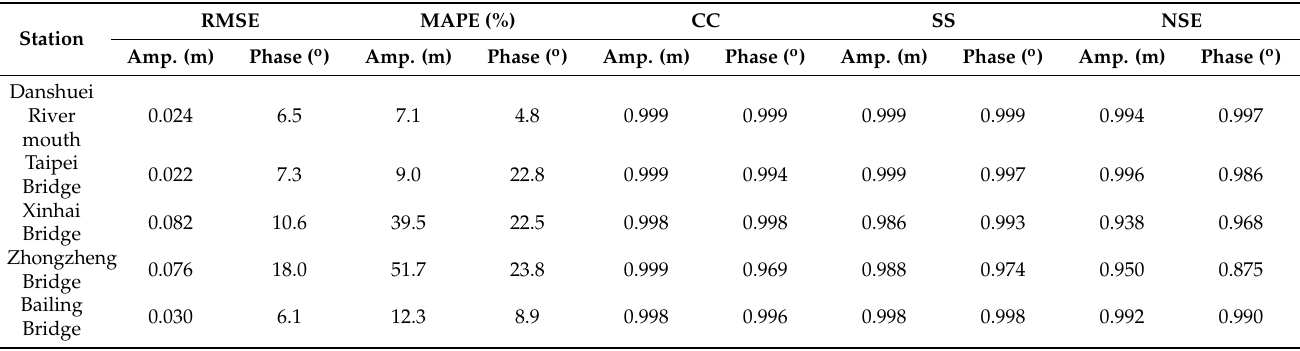
Figure 3. Comparison of the simulated and measured phases, including M 2 , S 2 , N 2 , K 1 , and O 1 , at the ( a ) Danshuei River mouth, ( b ) Taipei Bridge, ( c ) Xinhai Bridge, ( d ) Zhongzheng Bridge, and ( e ) Bailing Bridge. Table 3. Statistical errors between the simulated and measured tidal amplitudes and phases.